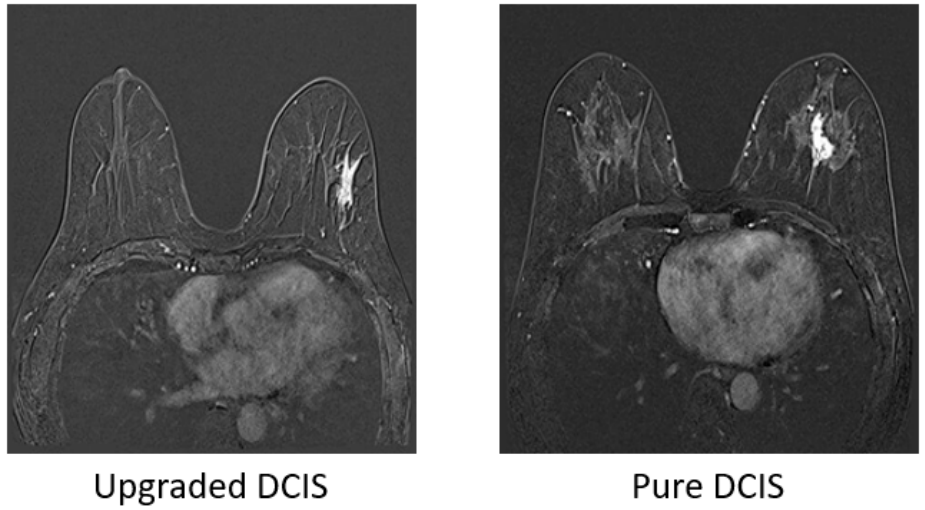
Figure 1. Examples of the first subtraction images (the 1st post-contrast minus pre-contrast images) for upgraded ductal carcinoma in situ (DCIS) and pure DCIS, both showing segmental heterogeneous non-mass enhancement which was hard to discriminate from each other. Table 1. The distribution of training, validation, and testing sets in two groups.